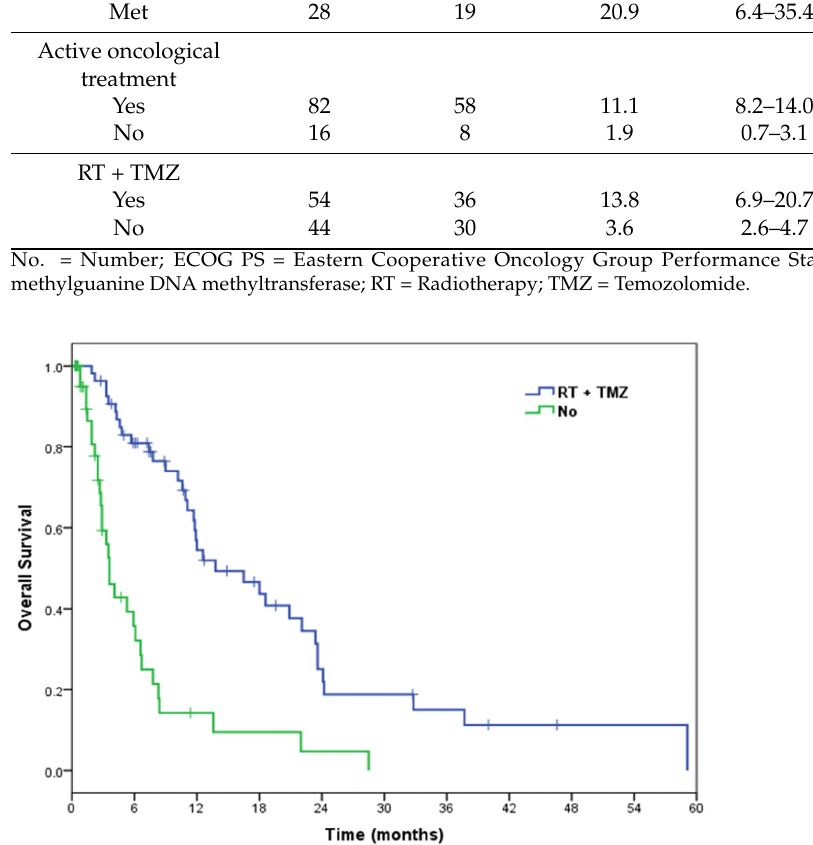
Table 4. Multivariate Analysis for OS with Cox regression. B